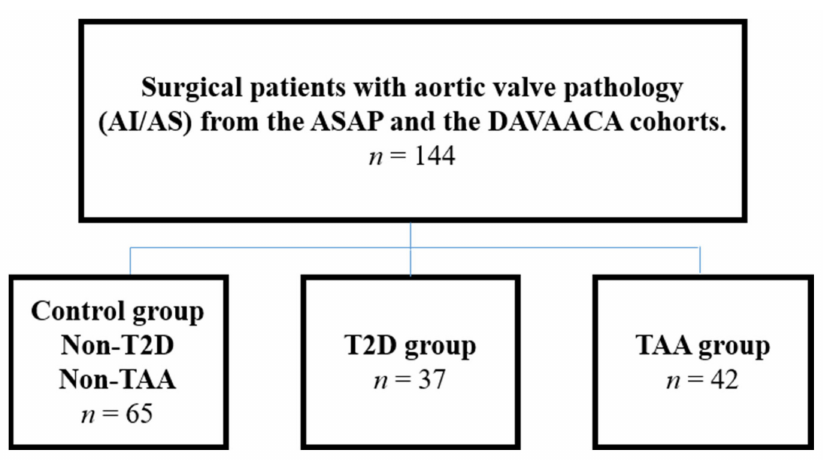
Figure 1. Flowchart of study